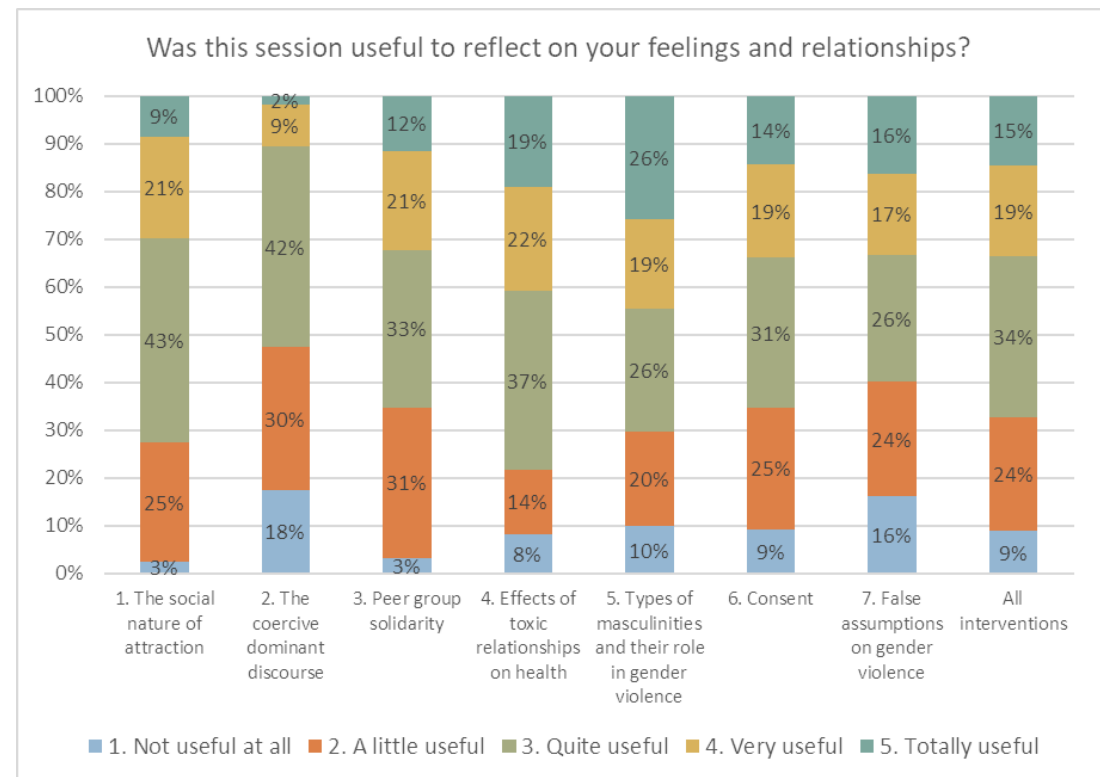
Figure 1. Utility perceived by adolescents of the different interventions.